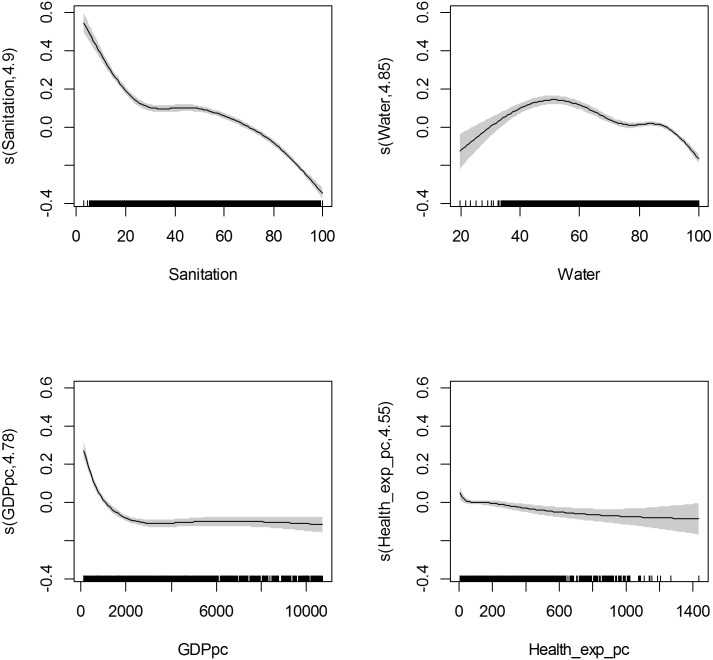
Partial residual plots showing impact on water and sanitation coverage at national level on log10 all-cause mortality in children under 5 years olda.aEach y axis shows the partial residual plot of the predictor with the relevant estimated degrees of freedom, with the partial residuals having a mean of zero. A decline of 1.0 along the y axis would equate to one log reduction in the outcome variable with the relevant change in the appropriate predictor assuming the other predictors remained constant. The grey shaded area represents the 95% confidence intervals. The small lines on the x axis represent the data points.